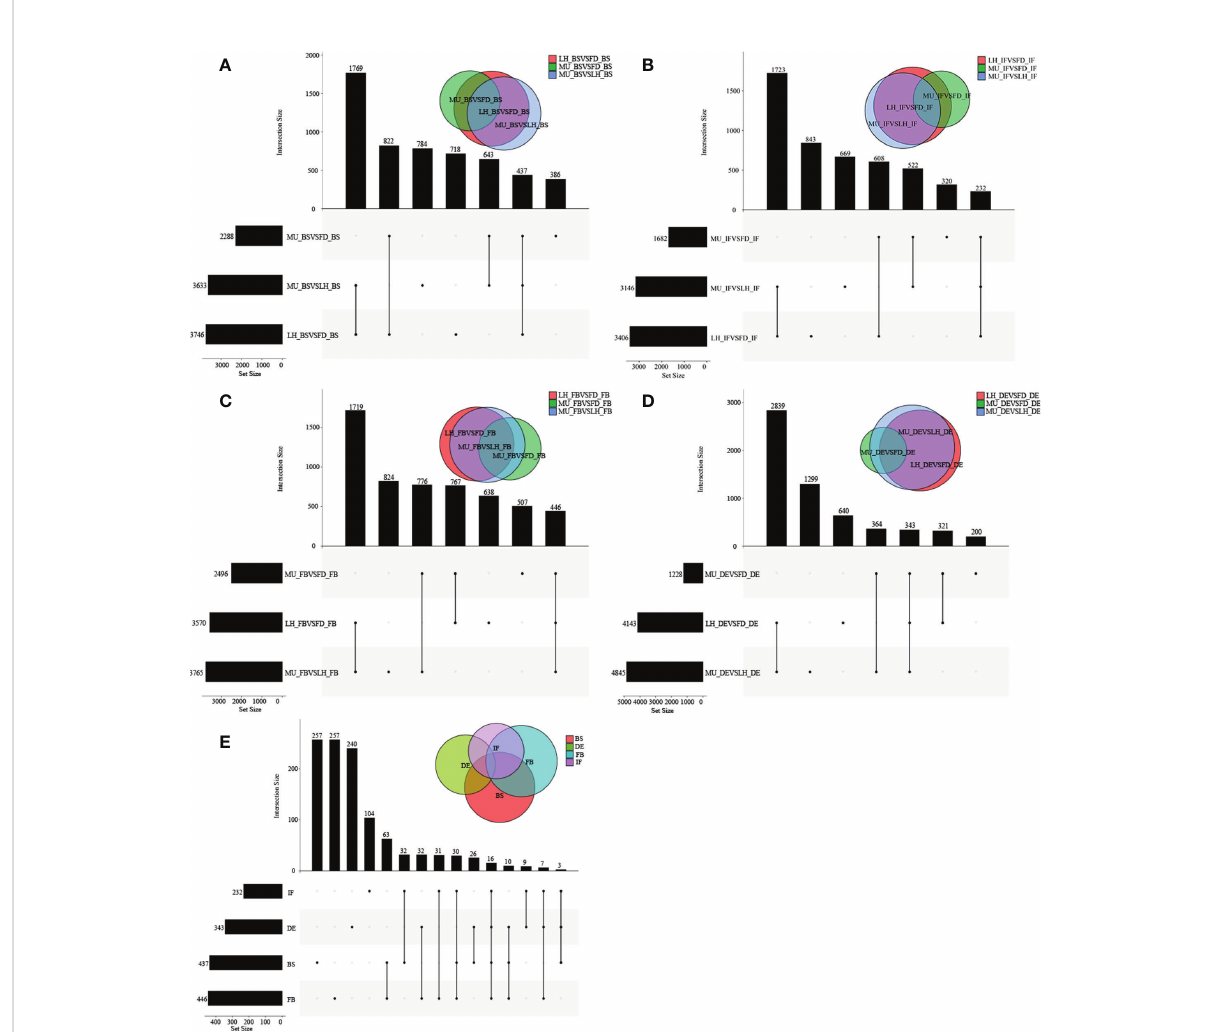
FIGURE 5 The distribution of DEGs across varieties at BS, IF, FB, and DE stages. (A) The distribution of DEGs across tree peony varieties (LH, MU and LH) at BS libraries. (B) The distribution of DEGs across tree peony varieties (LH, MU and LH) at IF libraries. (C) The distribution of DEGs across tree peony varieties (LH, MU and LH) at FB libraries. (D) The distribution of DEGs across tree peony varieties (LH, MU and LH) at DE libraries. (E) The distribution of intersection DEGs across the three tree peony varieties (LH, MU and LH) and across the four fl ower developmental stages (BS, IF, FB,